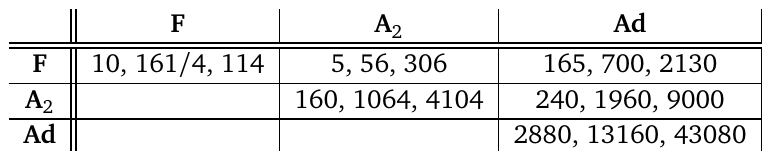
Table 8: The numerical values of d abcd ( R ( F ) = 1. For the “physicist” normalization l the choice l 2 value by 1 / 16.